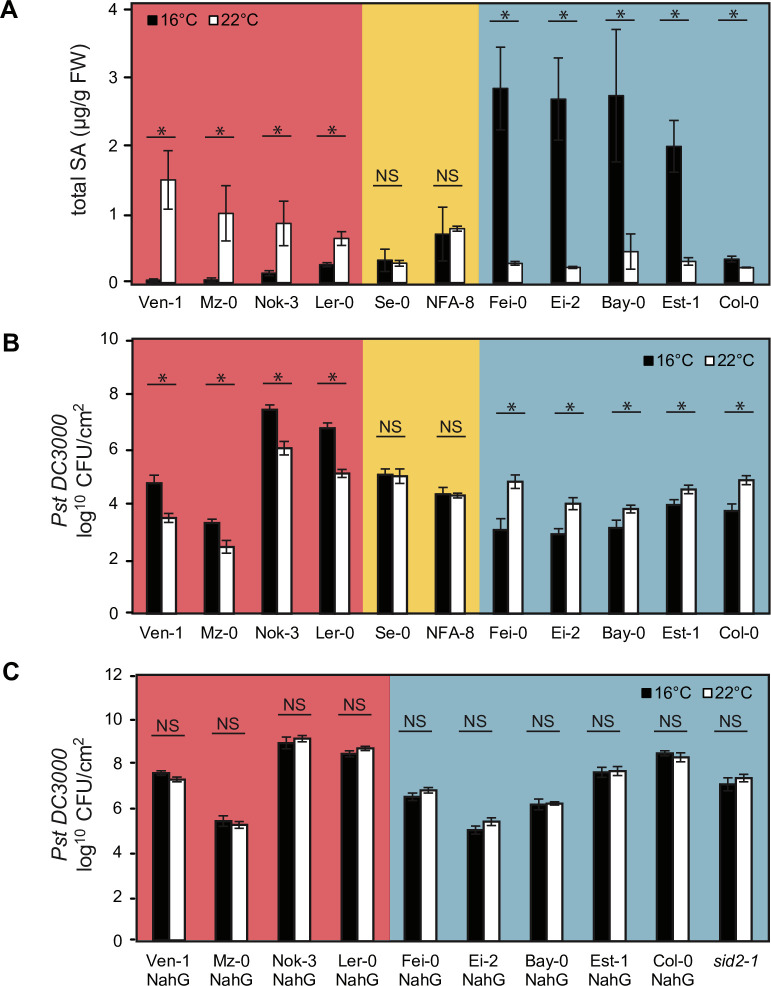
Temperature-modulated SA accumulation impacts resistance to Pst DC3000.A) Leaf total SA content in 5-week-old plants of 11 A. thaliana accessions grown at 16°C (n = 4 biological replicates) or 22°C (n = 3 biological replicates). Significant differences between temperature regimes after kruskal-wallis non parametric test with p-value<0.05 are indicated with a star. NS = not significant. Error bars represent standard error. Colour blocks indicate phenogroups B) Bacterial titres in leaves of 5-week-old plants of 11 A. thaliana accessions grown at 16°C or 22°C at 4 dafter spray-inoculation with Pst DC3000 (n = 18, three biological replicates). Significant differences between temperatures after Student t-test with p-value<0.05 are indicated on plot with a star. NS = not significant. Error bars represent standard error. Day 0 sample measurements are shown in S5 Fig. C) Bacterial counts in leaves of 5-week-old plants of 11 SA-deficient (NahG transgenic) A. thaliana accessions grown at 16°C or 22°C, at 4 d after infection with Pst DC3000 (n = 18 except for Ven-1 NahG where n = 12, three biological replicates). Significant differences between temperatures after Student t-test with p-value<0.05 are indicated with a star. NS = not significant. Error bars represent standard error. Day 0 sample measurements are shown in S5 Fig.